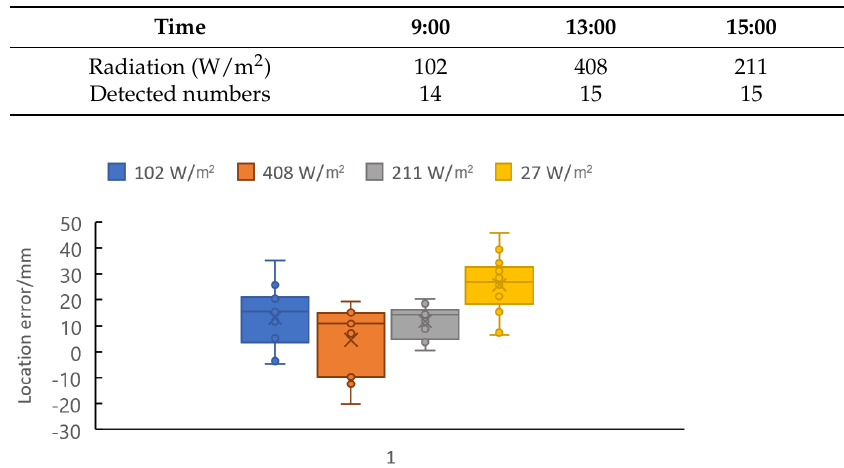
Figure 11. The location results in varying levels of radiation at a different time on a sunny day in the greenhouse.